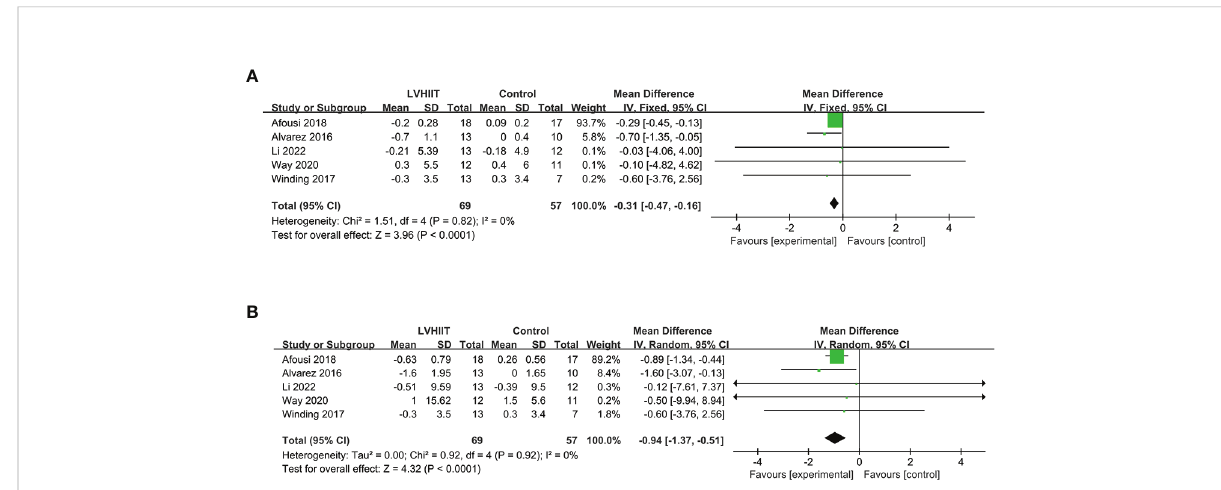
FIGURE 6 Forest plot for the meta-analysis of (A) body mass index and (B) body